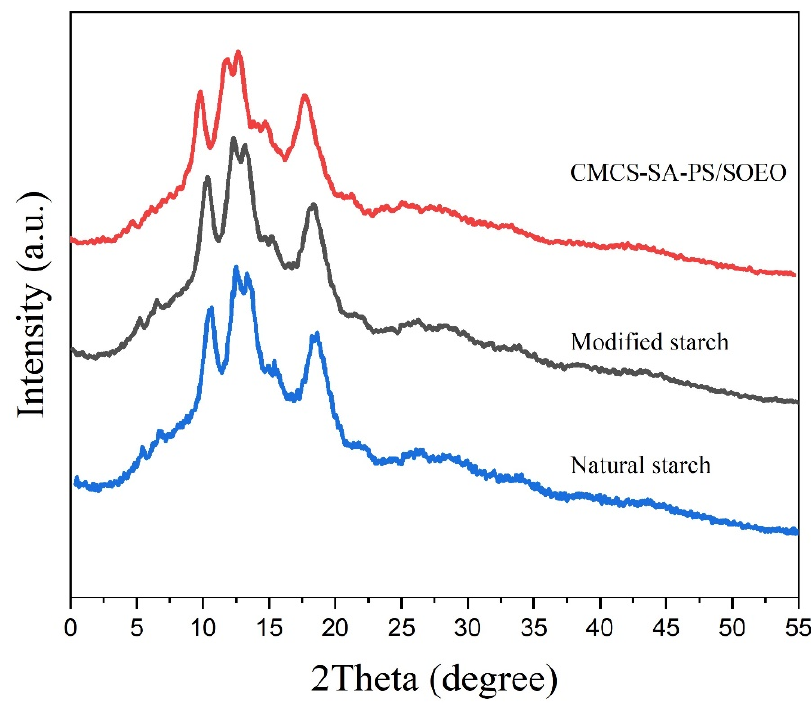
Figure 4. XRD pattern of natural starch; modified starch; and CMCS-SA-PS/EO.